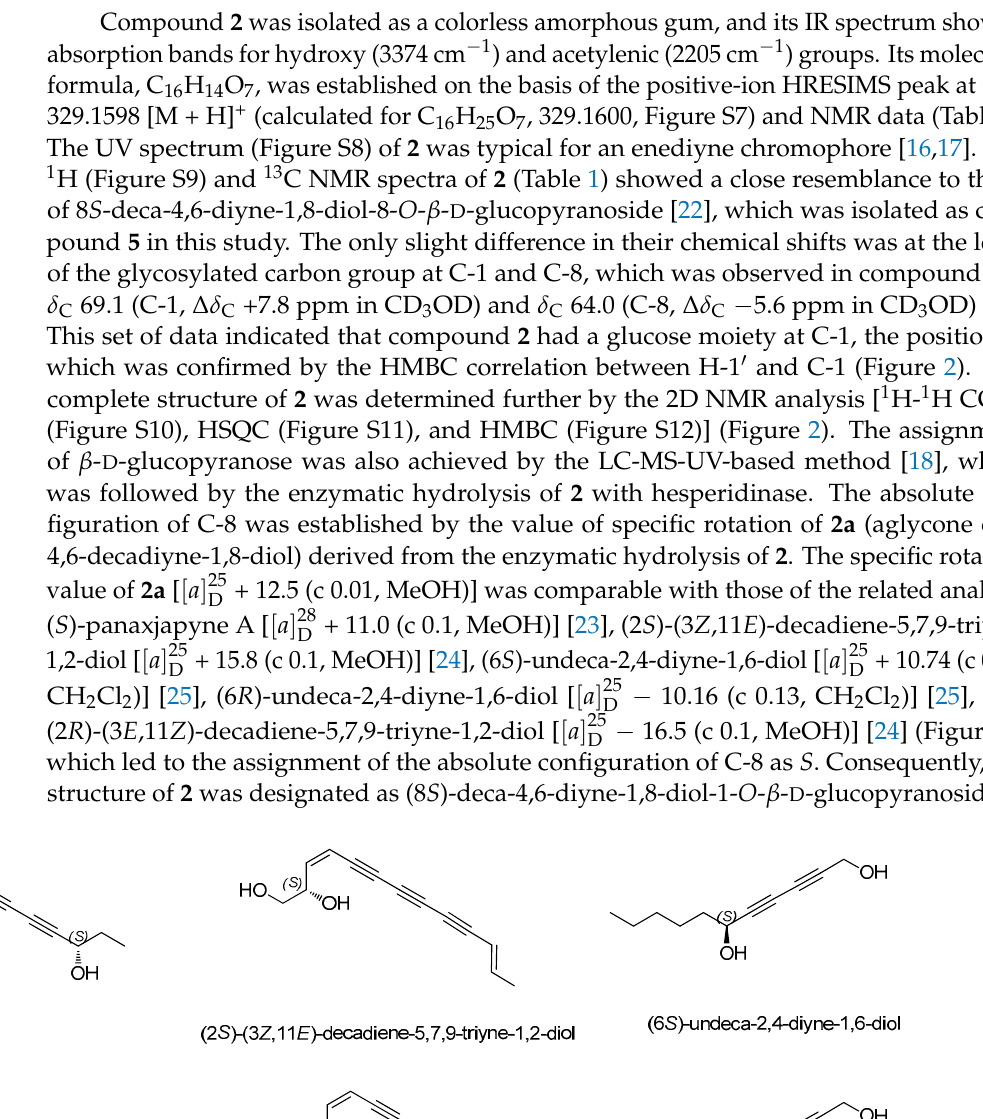
Figure 2. 1 H- 1 H COSY (bold blue lines) and key HMBC (red arrows) correlations of 1 and 2 . Compound 2 was isolated as a colorless amorphous gum, and its IR spectrum showed absorption bands for hydroxy (3374 cm − 1 ) and acetylenic (2205 cm − 1 ) groups. Its molecular formula, C 16 H 14 O 7 , was established on the basis of the positive-ion HRESIMS peak at m / z 329.1598 [M + H] + (calculated for C 16 H 25 O 7 , 329.1600, Figure S7) and NMR data (Table 1). The UV spectrum (Figure S8) of 2 was typical for an enediyne chromophore [16,17]. The 1 H (Figure S9) and 13 C NMR spectra of 2 (Table 1) showed a close